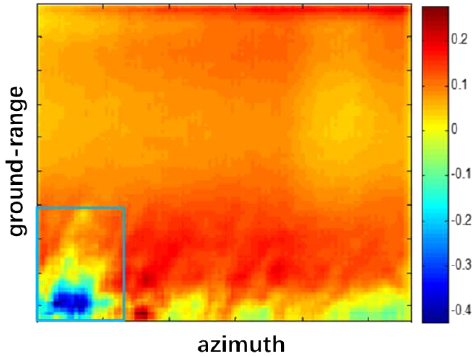
Figure 8. Multi-look interferometric phase on a 1-km grid. Phases in the blue box corresponds to the internal wave area.